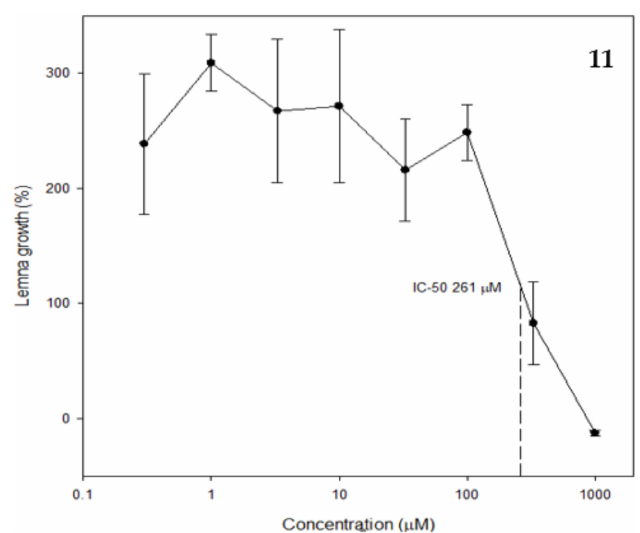
Figure 3. IC 50 plot for confertin against Lemna paucicostata after seven